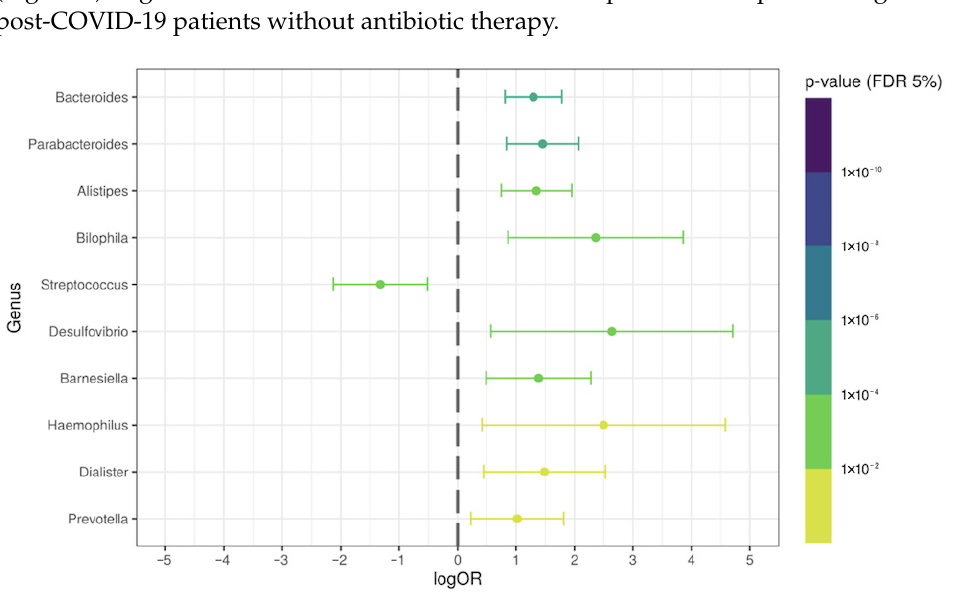
Figure 4. Differential genera relative abundance analysis of the intestinal microbiota in post-COVID-19 patients without ATB therapy (N = 35), compared with control subjects (N = 71).